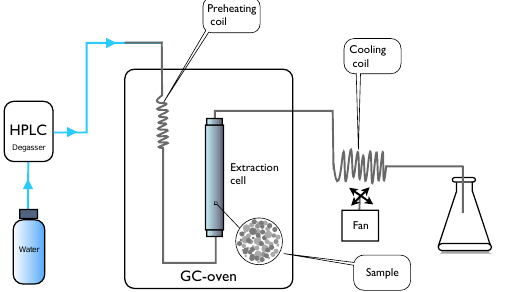
Figure 1. Schematic picture of the in-house stainless-steel column pressurized hot water extraction (PHWE) system.